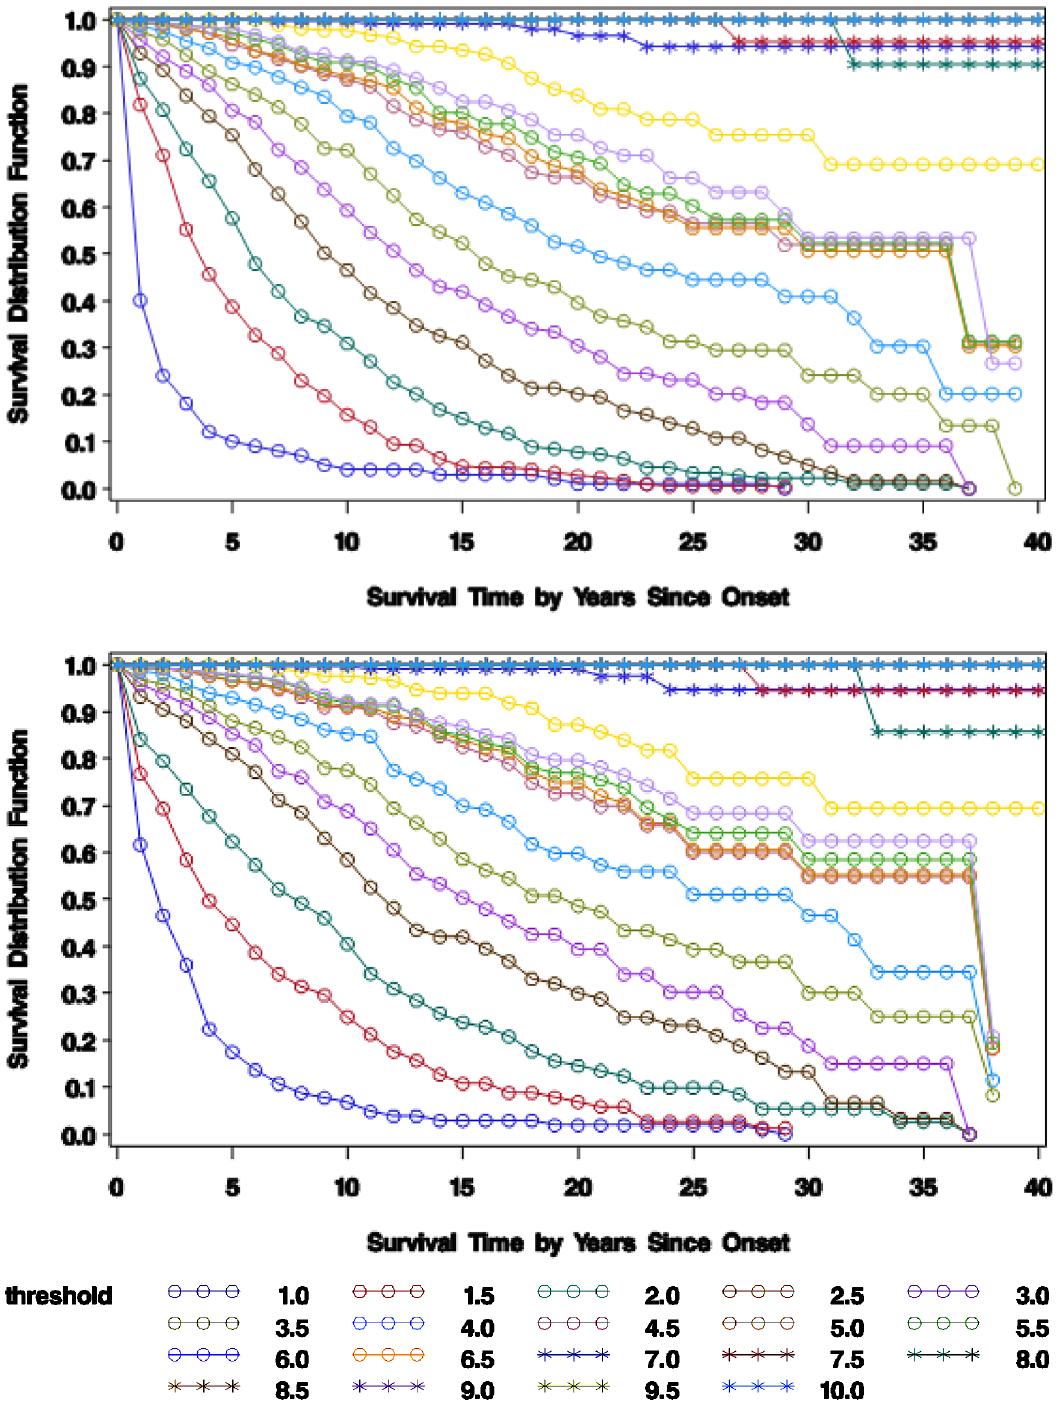
Figure 4. Kaplan-Meier estimates of natural history survival time at EDSS disability endpoints for 408 eventually-DMD-treated patients, assuming midpoint (top) or maximum (bottom) survival time, Nova Scotia, 1979–2010. Footnote: The study group is a synthetic onset cohort of 408 definite relapsing-onset multiple sclerosis patients who were eventually treated with disease-modifying-drugs in period 1 August 1998–31 December 2010 and who had an assessed year-of-onset and at least two natural history EDSS clinical observations in period 1979– 2010. The top graph shows Kaplan-Meier survival distribution function estimates at irreversible endpoints EDSS 1–9, assuming midpoint survival time (obs + Exp=3702). The bottom graph shows Kaplan-Meier survival distribution function estimates at irreversible endpoints EDSS 1–9, assuming maximum survival time (obs=2170). obs=an EDSS clinical observation, including assessed year-of-onset. Exp=an expected EDSS midpoint measure.